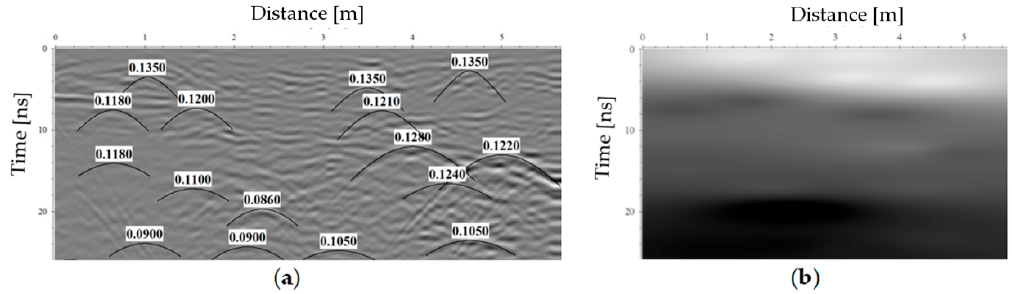
Figure 13. Electromagnetic wave (EMW) velocity field estimation for profile 5 before the migration using a 900 MHz antenna. ( a ) The method of hyperbola fitting for estimating velocity; ( b ) Velocity field, calculated on the basis of velocity point estimation (the lighter colour represents higher while the darker colour represents lower velocity of EMW propagation).